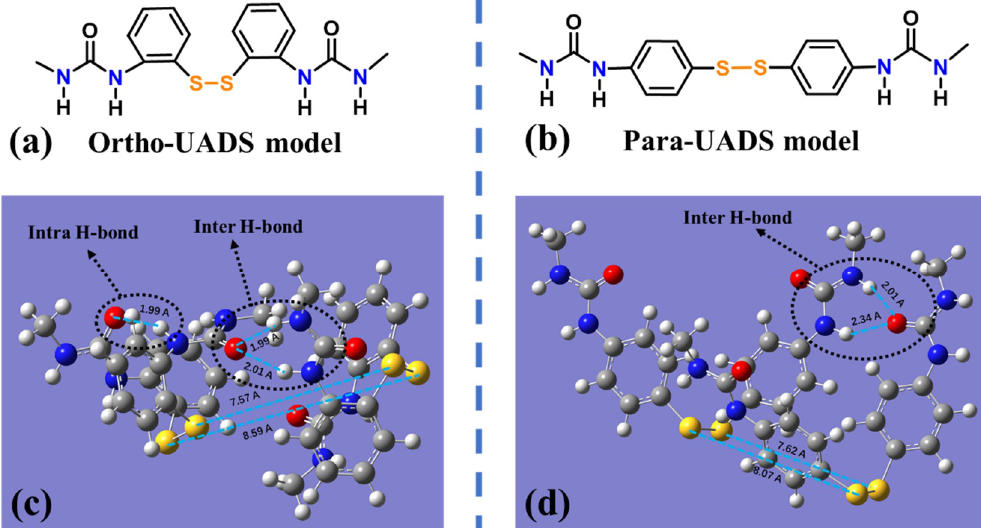
Figure 3. ( a ) Structural model of the aromatic disulfide with ortho-urea substituents (ortho-UADS); ( b ) structural model of the aromatic disulfide with para-urea substituents (para-UADS); ( c ) simulated assembly models of two ortho-UADS; ( d ) the simulated assembly models of two para-UADS.